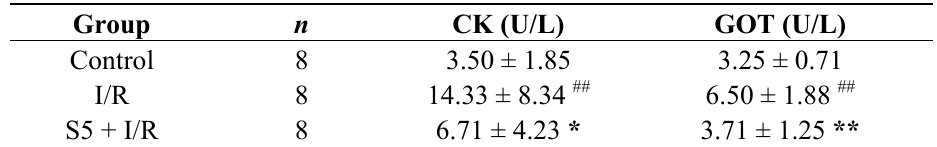
Table 1. The activities of creatine kinase (CK) and glutamic-oxaloacetic transaminase (GOT) in the coronary perfusion